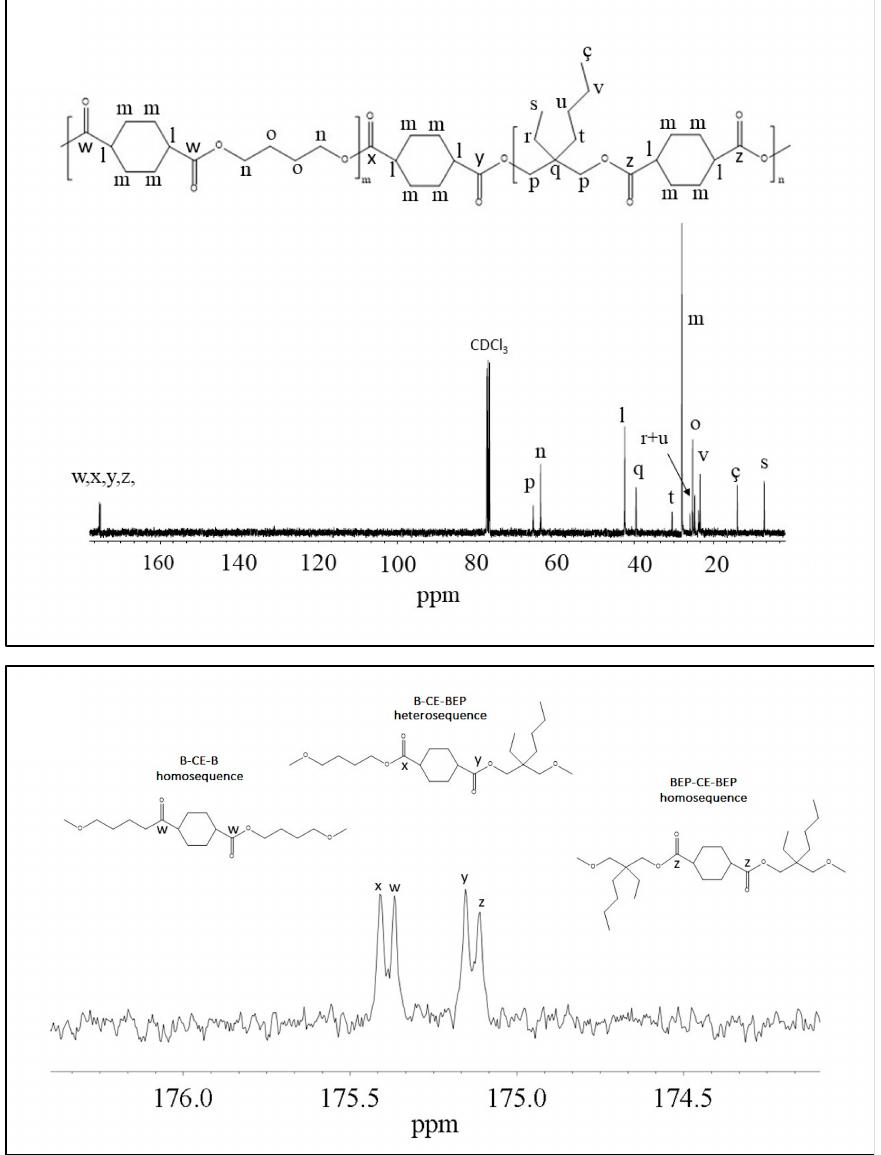
Figure 3. Top : 13 C-NMR spectrum of P(BCE 65 BEPCE 35 ) with resonance assignments; Bottom : Enlargement of 13 C-NMR spectrum in the region 176.50–174 ppm, together with the schematic representation of B-CE-B, B-CE-BEP, and BEP-CE-BEP triads.